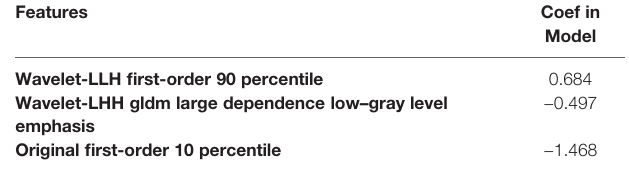
TABLE 8 | The coef fi cients of features in the model.